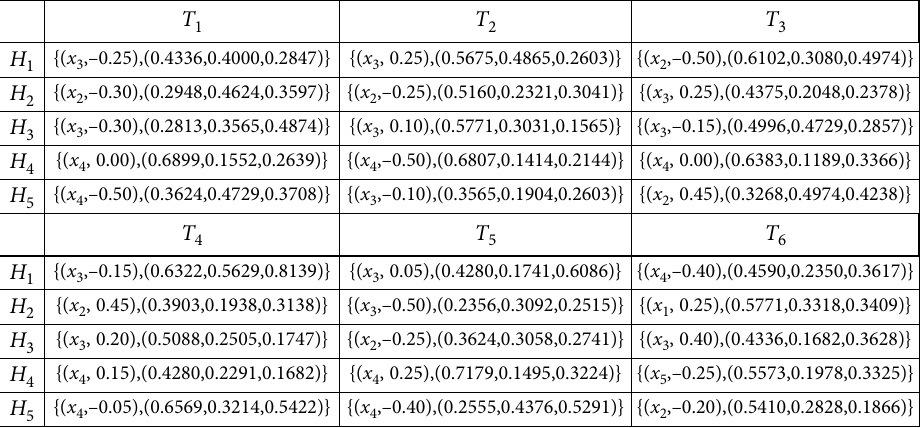
Table 4. The fused results by SVN2TLWA operator T 1 T 2 T 3 H 1 {( x 3 ,–0.25),(0.4336,0.4000,0.2847)} {( x 3 , 0.25),(0.5675,0.4865,0.2603)} {( x 2